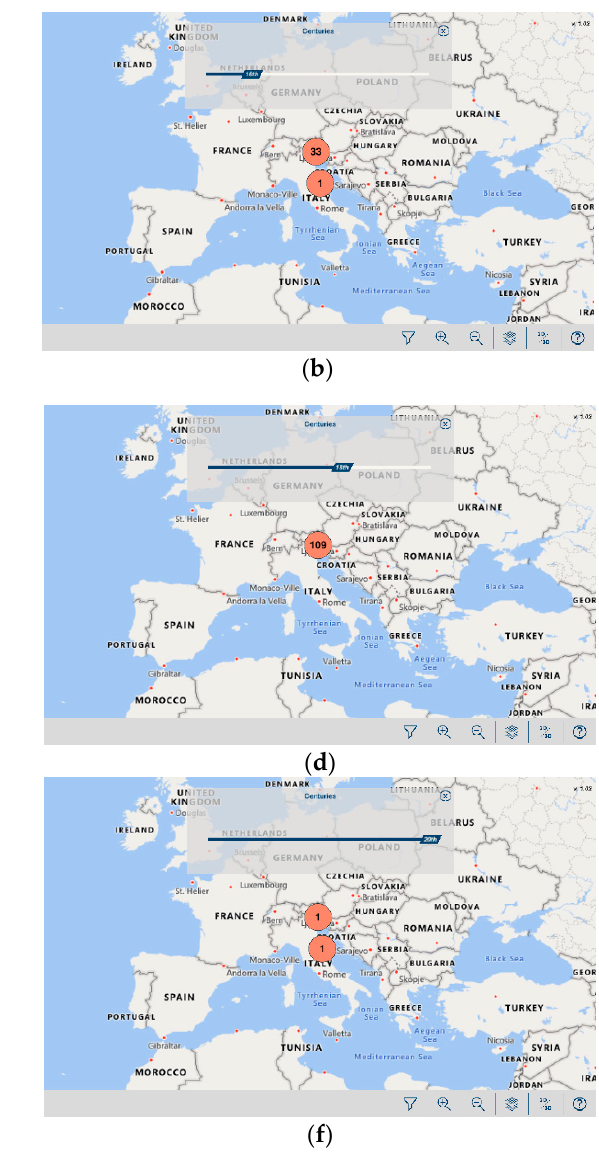
( b ) ( c ) Figure 11. Example of objects that have multiple locations, where: ( a ) results of a query; ( b ) depiction of objects with multiple locations; and ( c ) details of one of the objects. The objects in Figure 11 might also belong to different time spans. This can be checked when visualizing objects in different centuries, as shown in Figure 12. For instance, the sum of objects that are placed in Venice is 233, where it should be 214 if none of them belongs to